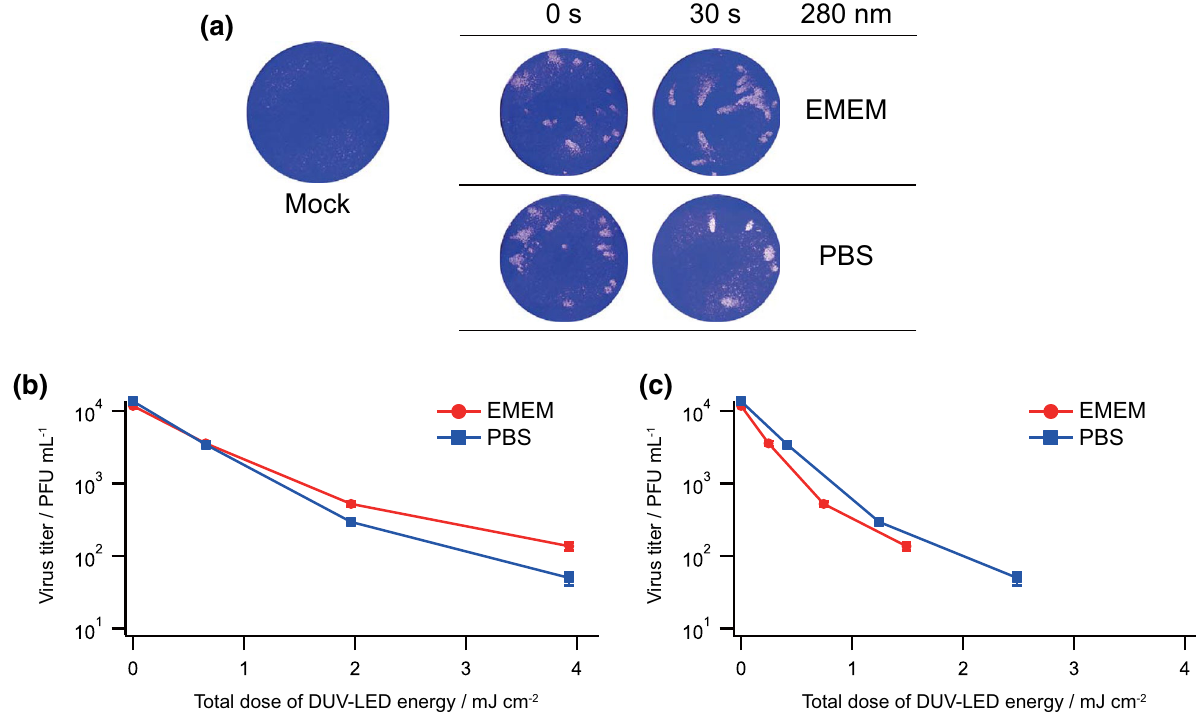
Figure 3. Effects of culture media on the inactivation efficacy of SARS-CoV-2 at 280 nm DUV. ( a ) Plaque assays. Virus stocks were diluted with EMEM containing 2% FBS (EMEM) or PBS containing 2% FBS (PBS). The diluted samples were exposed to DUV-LED at 280 nm wavelength for various irradiation time periods (5, 15, and 30 s). The irradiated samples were appropriately diluted, if necessary, for plaque assays as described in Fig. 1b. Representative data (irradiation for 0 and 30 s) from six independent assays are shown. ( b and c ) Inactivation efficacy at various total doses of DUV-LED energy with ( c ) and without ( b ) normalization by transmittances. The transmittances of the culture media of the virus stock diluted with EMEM containing 2% FBS and that with PBS containing 2% FBS at 280 nm were 37.9% and 63.3%, respectively. Mean values (M) ± standard errors (SE) are shown (N =